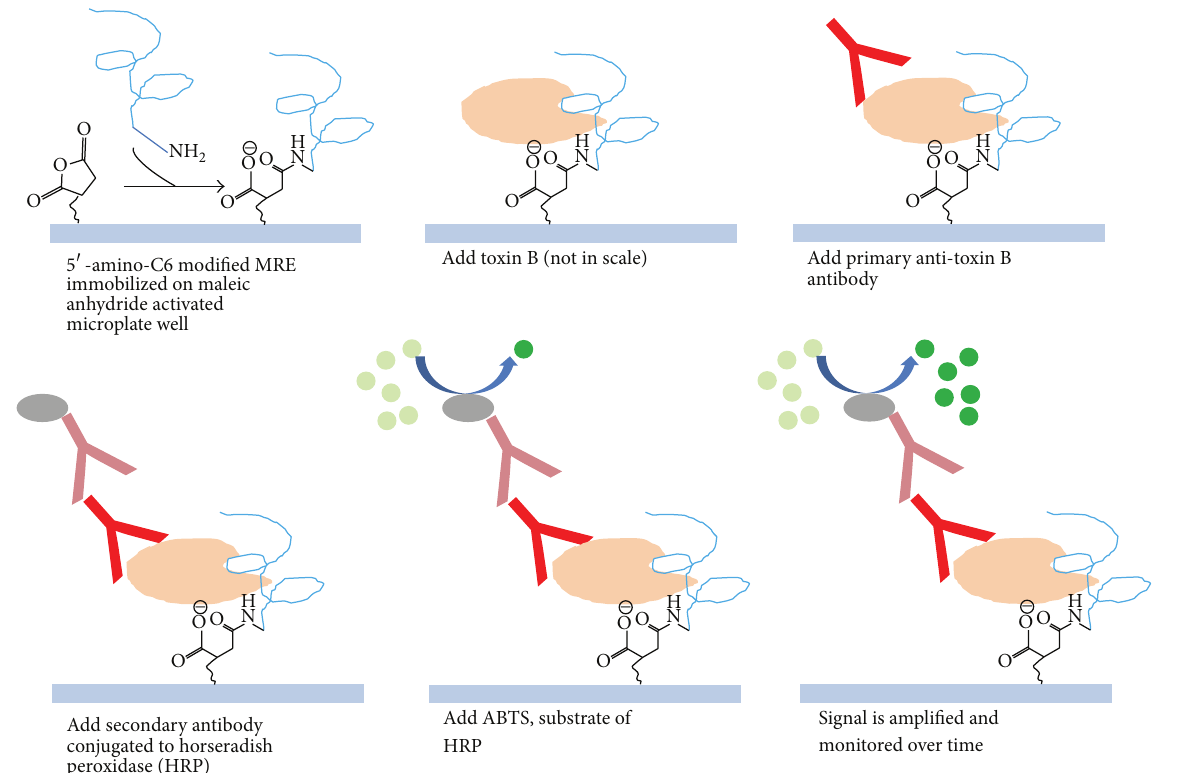
Figure 3: Illustration of the modified ELISA assay. The ssDNA MRE was used as the capturing element in the modified sandwich ELISA assay and signal is amplified by using secondary antibody conjugated to horse radish peroxidase (HRP).